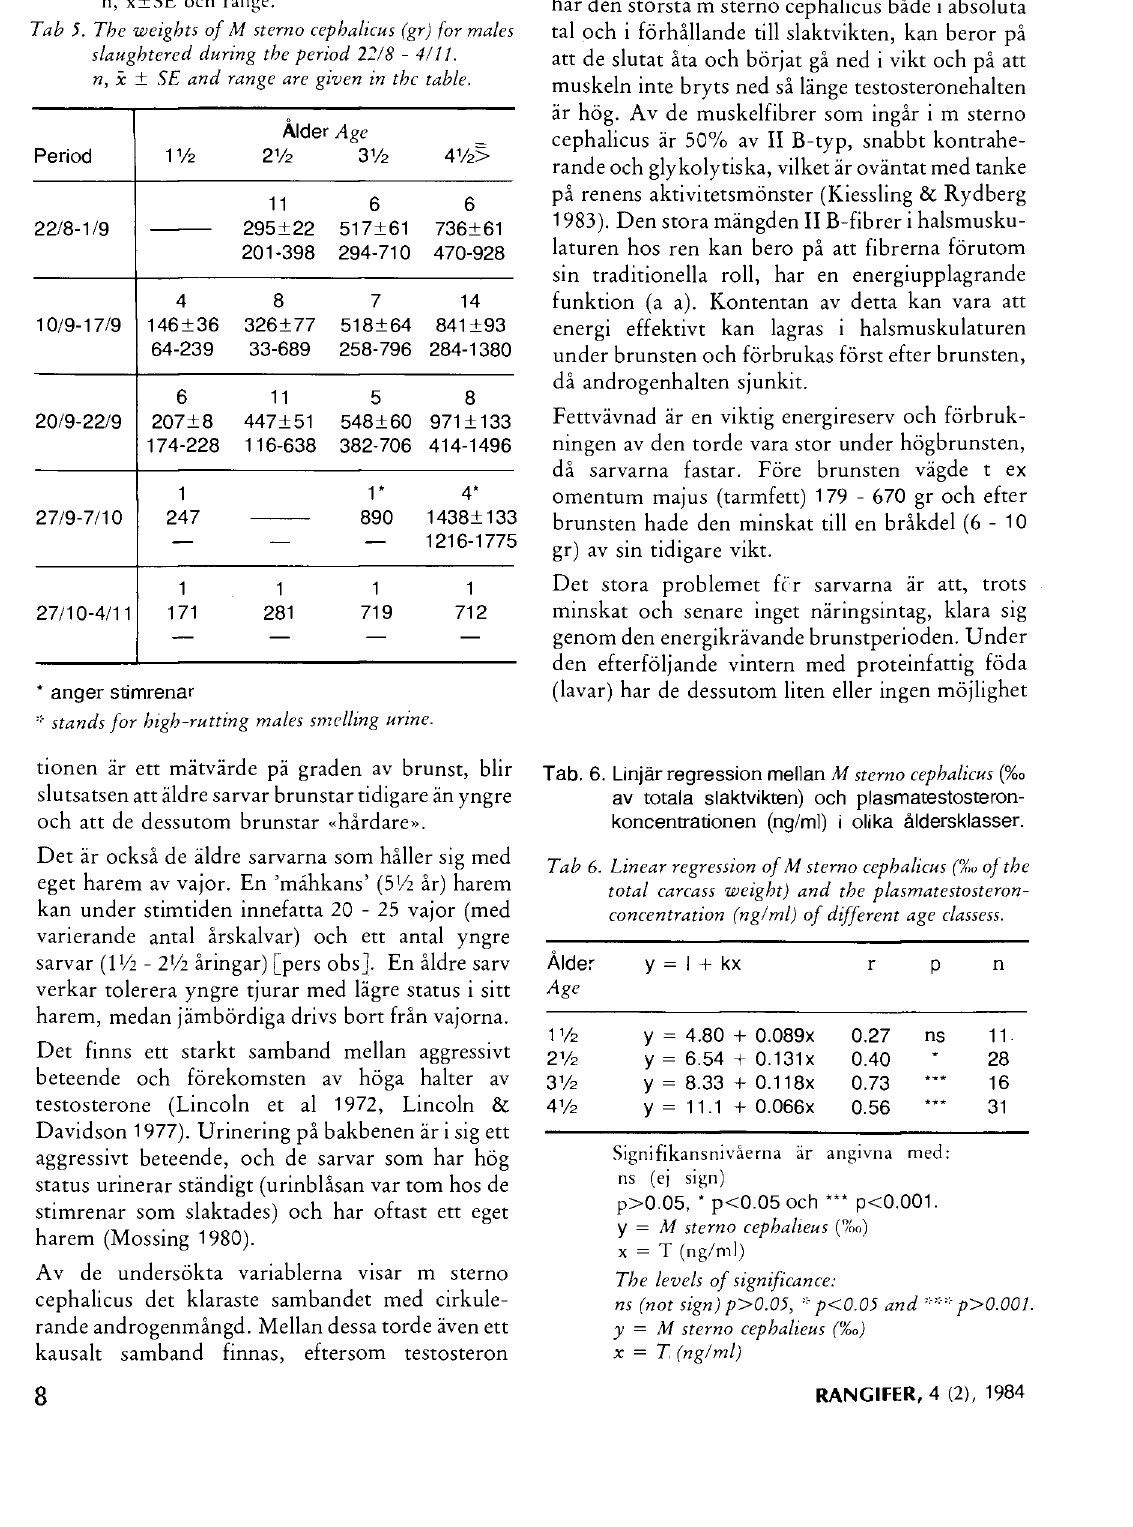
Tab. 5. Vikter av M stemo cephalieus (gr) hos sarvar slaktade den 22/8 -4/11. Siffrorna i tabellen anger n, x±SE och range. Tab J. The weights of M stemo cephalieus (gr) for males slaughtered during the period 22/8 - 4/11.